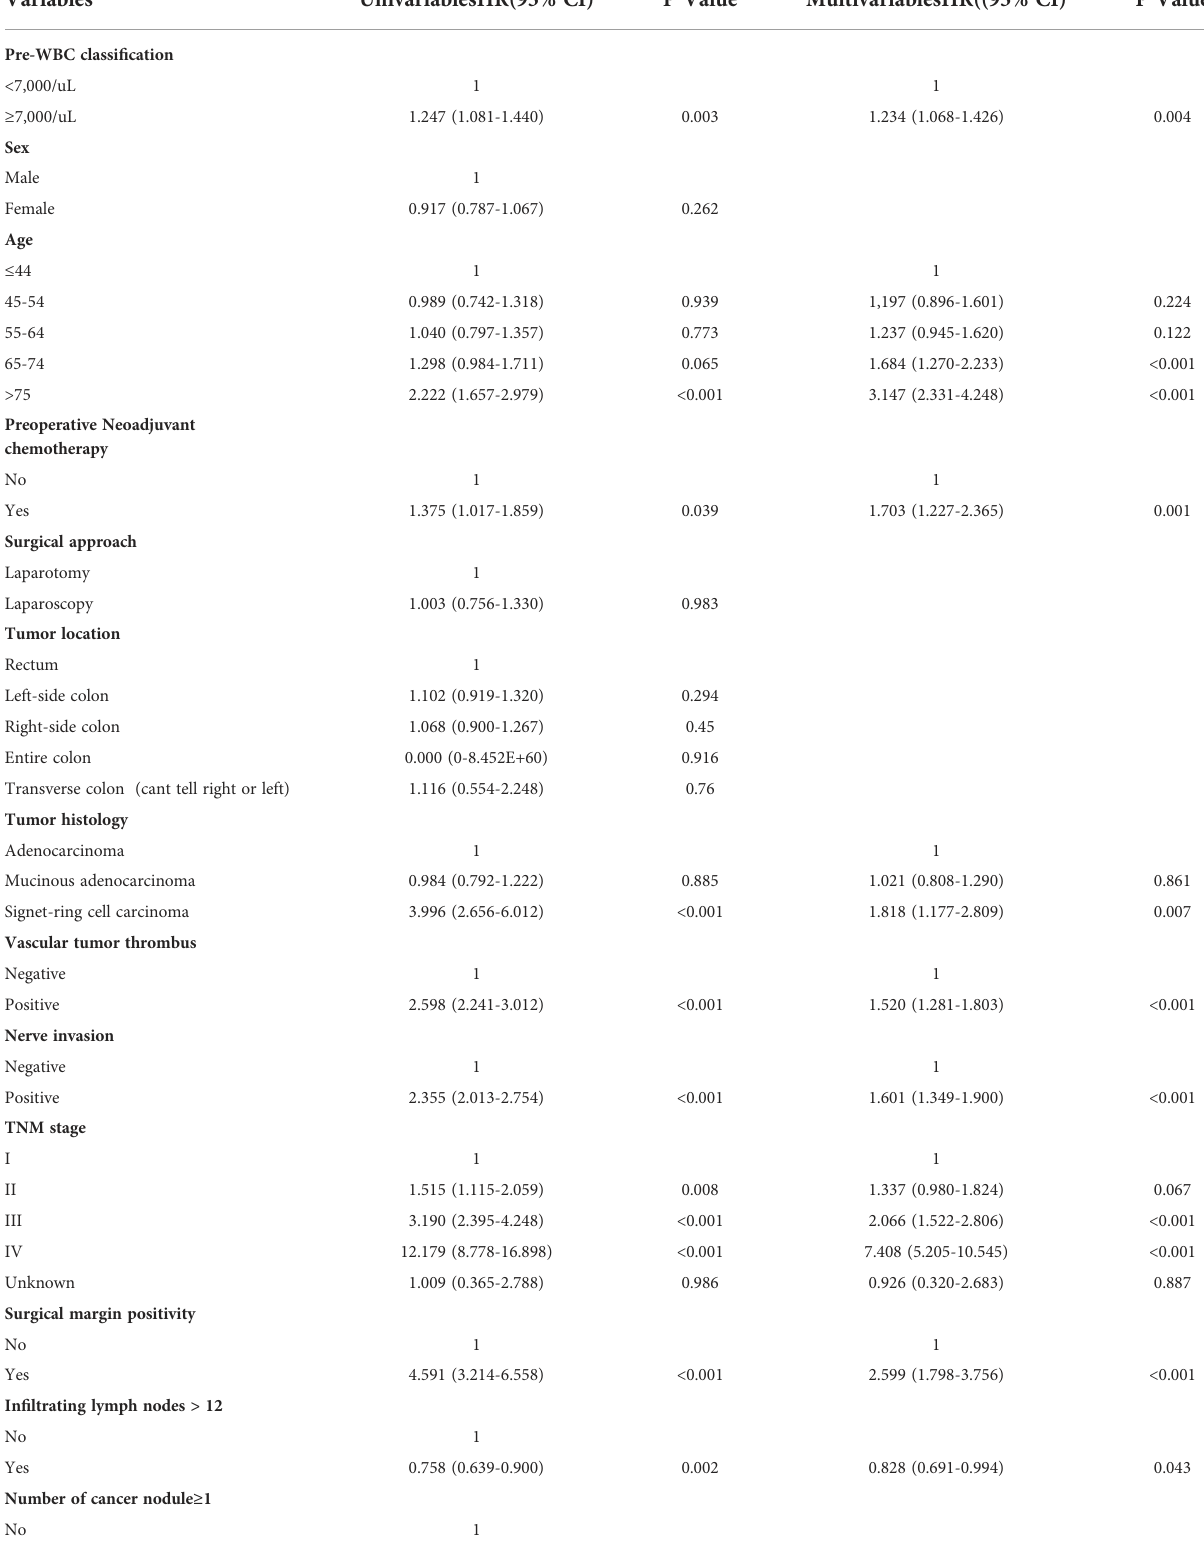
TABLE 2 Univariable and multivariable cox regression analysis for overall survival in the propensity score matched